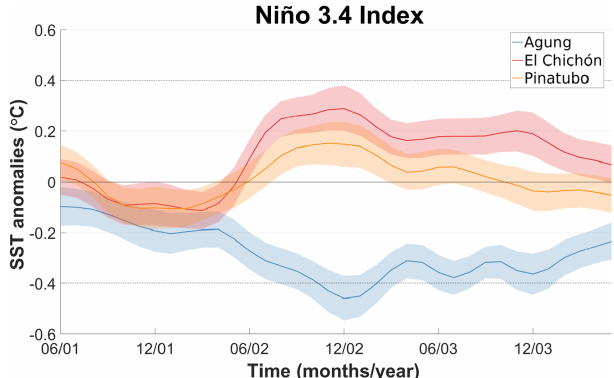
Figure A13. Ensemble mean changes in the Niño 3.4 index after each eruption. The 3-year climatology is subtracted to calculate the anomalies. Shading represents twice the standard error of the mean using an approximate 95% confidence interval.